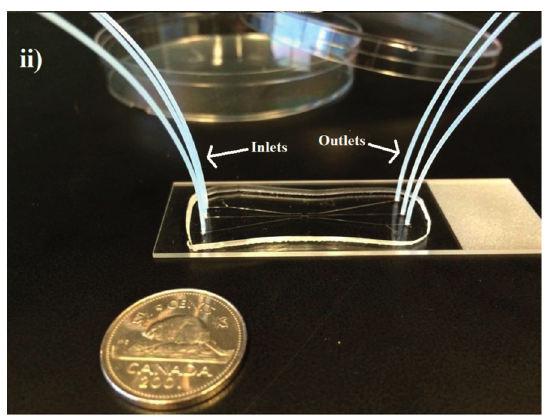
Figure 3. Final fabricated PDMS device bonded to a glass cover slip with inlet and outlet tubes added ( i ) and ( ii ). A Canadian five cent coin is used to show the relative scale of the completed device. ( i ) The microfluidic device as viewed from above showing the